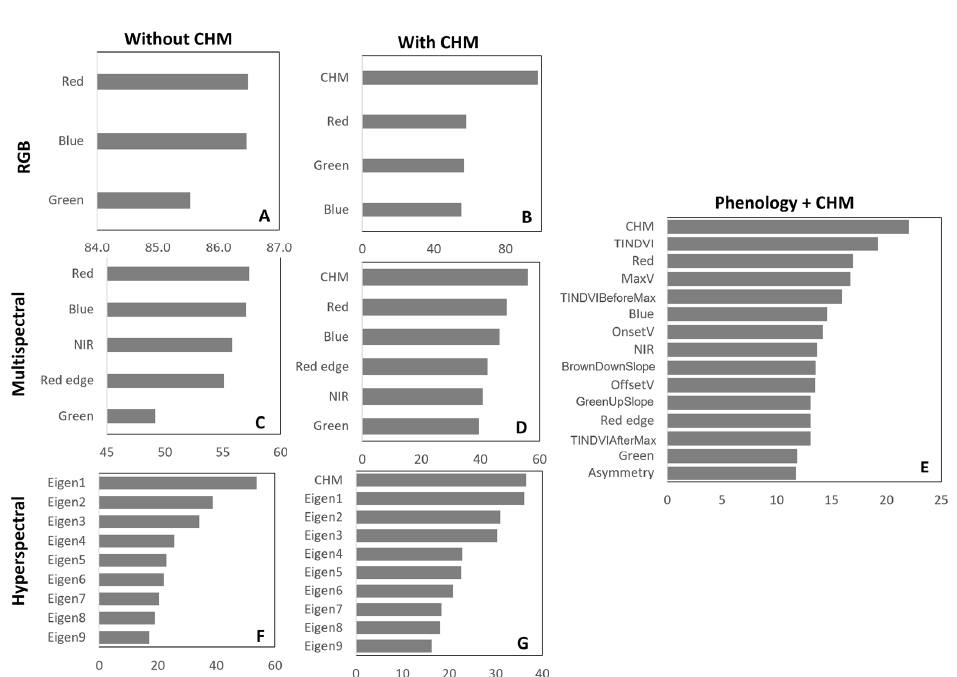
Table 4. Random forest (RF) model parameters and cross-validation statistics for each data-fusion product. The number of random variables ( mtry ), OOB error, and Kappa cv are described for each product. Tree number was constant at 500 for all RF analyses. See text for descriptions of OOB error and Kappa cv . Variable importance statistics revealed CHMs to be the most important bands in- RF Model Data-Fusion Product cluded in all RF models (Figure 5). The CHM within the “ Hyperspectral + CHM ” data-fu- sion classification had the highest variable importance, followed by steadily decreasing MNF eigenvalue bands. These decreasing MNF eigenvalue bands also explained the most spectral variability in the “ Hyperspectral ” data-fusion product. Similarly, considering the “ Multispectral + CHM + Phenology ” data-fusion product, the most important variable was the CHM, followed by phenometrics: (i) time-integrated NDVI, (ii) maxNDVI, and (iii) time-integrated NDVI before maxNDVI, as well as the red band. These patterns were sim- ilar for the “ Multispectral + CHM ” and “ Multispectral ” product, as the highest to lowest variable importance values were CHM (only in “ Multispectral + CHM ”), red, blue, red- edge, NIR, and green bands (Figure 5). The highest to lowest variable importance values for “ RGB + CHM ” and “ RGB ” data-fusion products were the CHM (only in “ RGB + CHM ”), red, blue, and green bands.